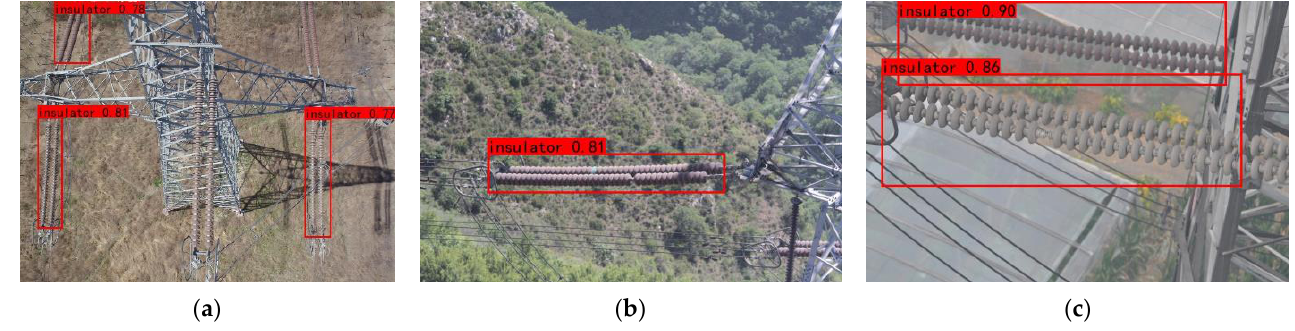
Figure 12. Detection result of the original model: ( a ) three insulators have been detected; ( b ) only one insulator has been detected, and the defect has not been detected; ( c ) two insulators have been detected, and the defect has not been detected.